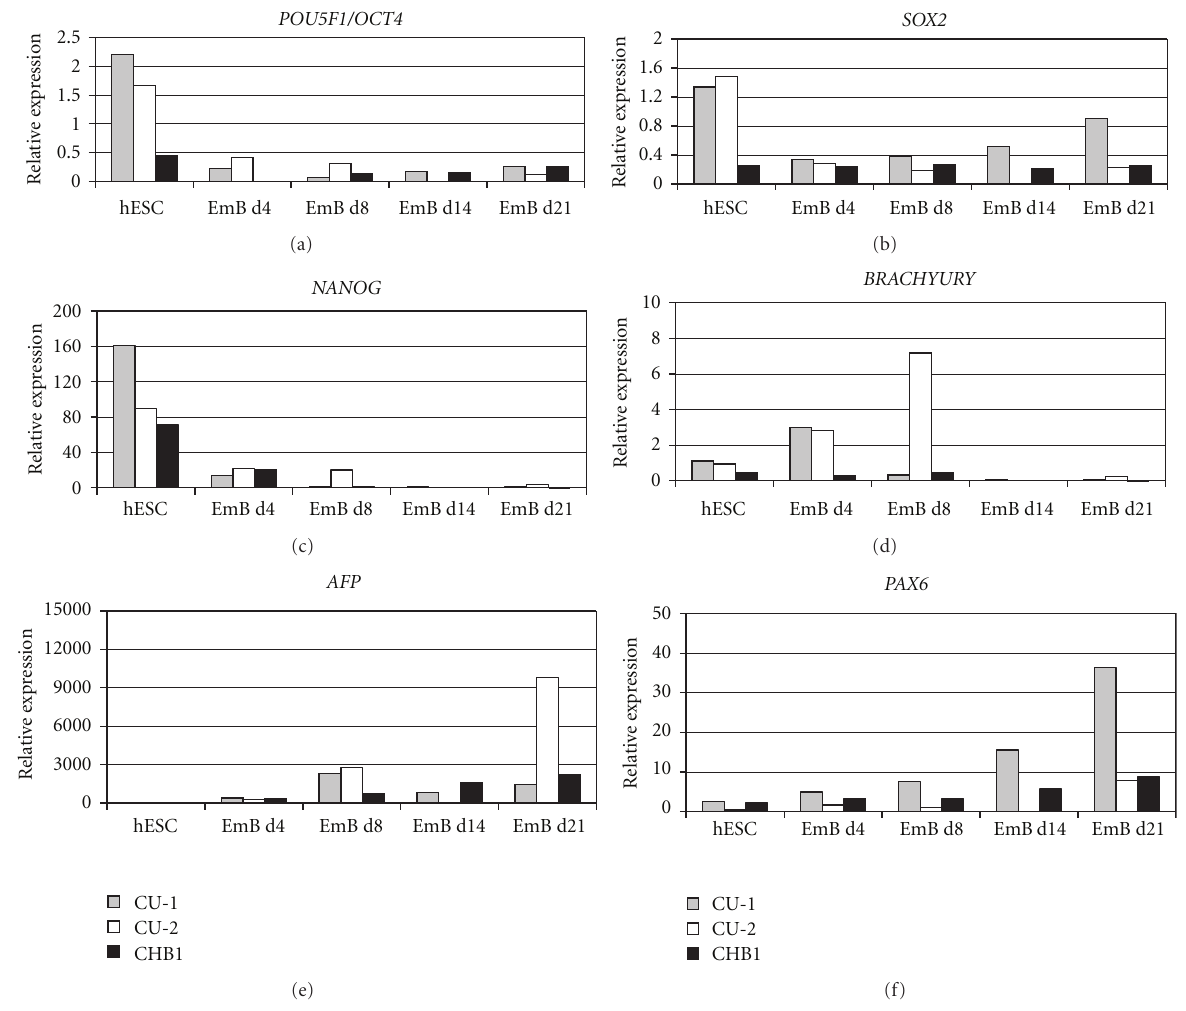
Figure 3: Gene expression analysis by qRT-PCR. Expression of pluripotency markers POU5F1/OCT4 (a), SOX2 (b), NANOG (c) and di ff erentiation markers BRACHYURY (e), AFP (f), and PAX6 (g) in undi ff erentiated CU1, CU2, and CHB1 hESC colonies (hESC) and corresponding embryoid bodies (EmB) harvested on days 4, 8, 14, and 21 (EmBd4, EmBd8, EmBd14, and EmBd21, resp.). Expression levels were normalized to expression of GAPDH .